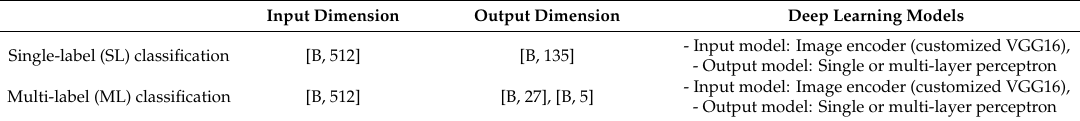
Figure 6. ROC curves for the different combinations of the CNN and RNN for fashion product research. Table 10. Network architectures of conventional methods. B represents the batch size.